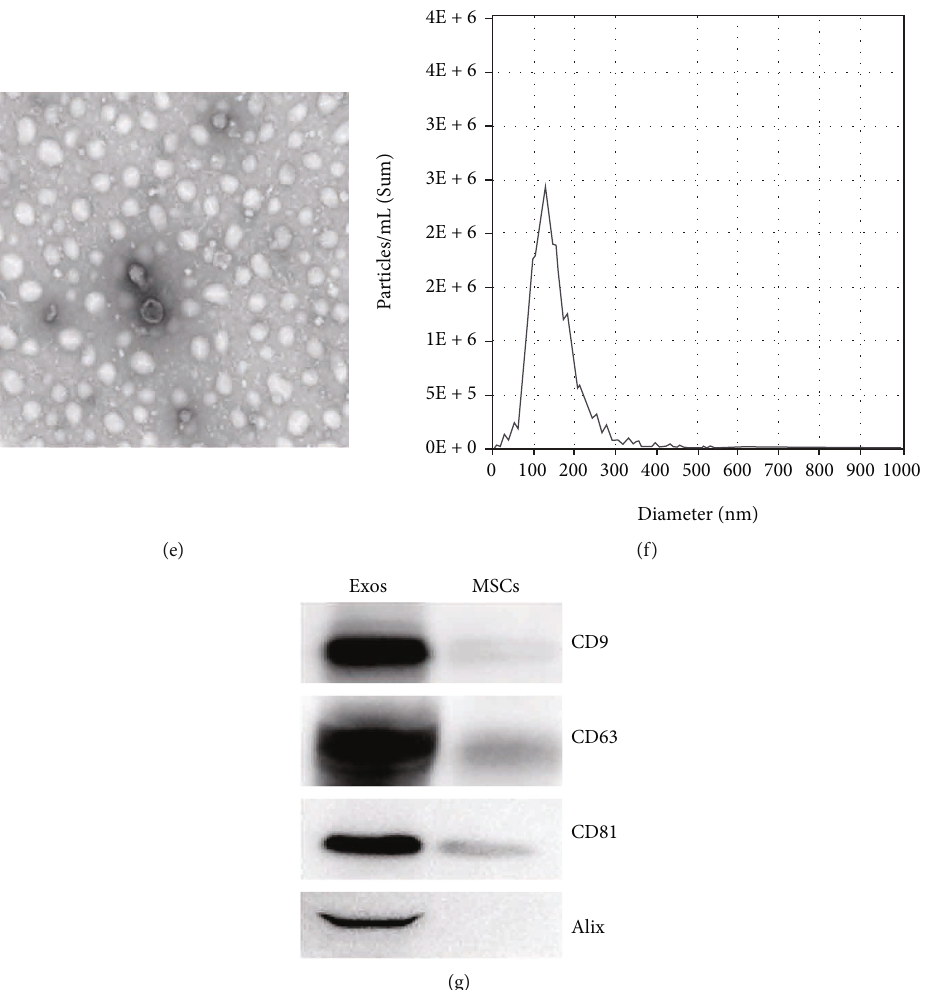
Figure 3: Characterization of umbilical cord-derived MSCs and MSC-exosomes. (a) Cell morphology of MSCs in single culture and MSCs was showing normal morphology in culture conditions ( × 100). (b, c) The di ff erentiation potential of MSCs into two predominant lineages: adipogenesis and osteogenesis ( × 100). (d) The expression of surface markers of MSCs (HLA-DR, CD14, CD19, CD34, CD45, CD73, CD90, and CD105) was detected by fl ow cytometry. (e) The morphology of MSC-exosomes was observed under transmission electron microscopy ( scale bar = 200nm ). (f) Particle size distribution of MSC-exosomes was analyzed by nanoparticle tracking analysis. (g) The expression of markers of exosome MSCs (CD9, CD63, CD81, and Alix) was detected by western